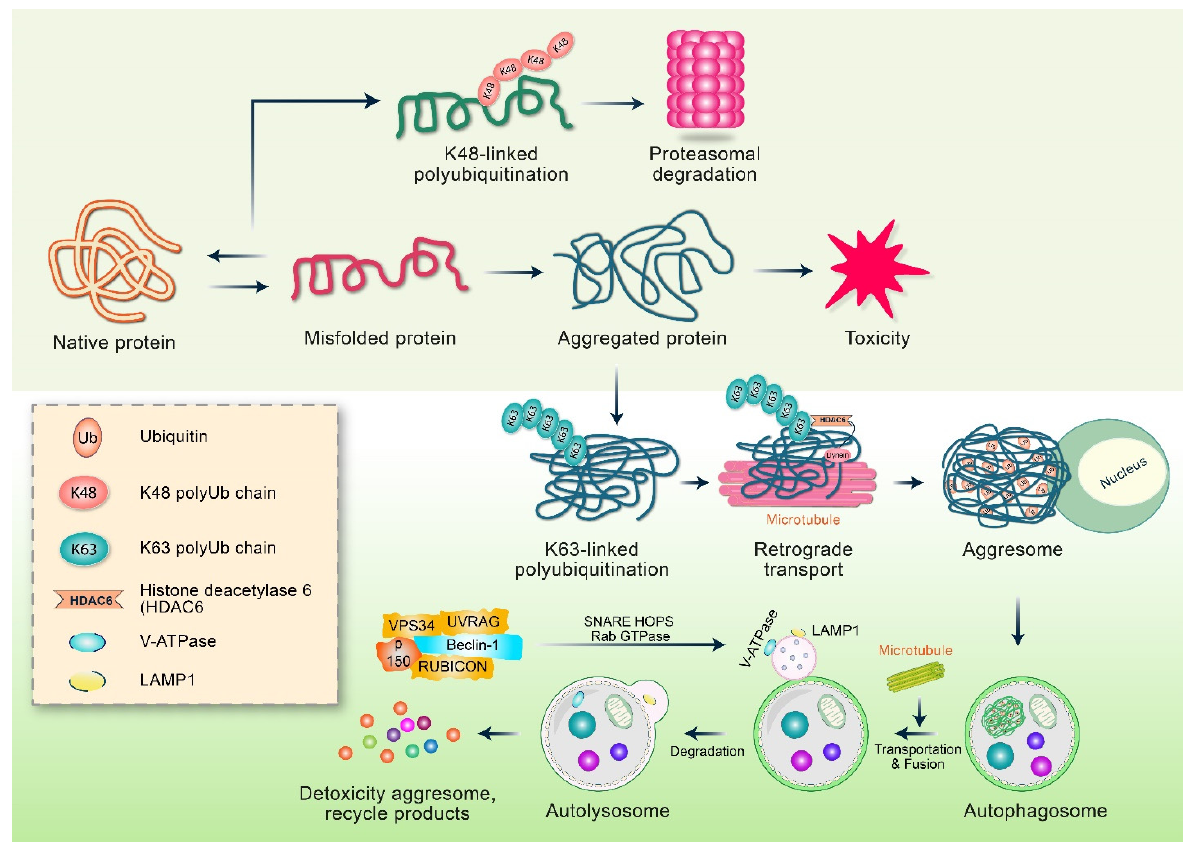
Figure 4. The regulation of aggresome–autophagy pathway. Aggresome and autophagy are regulated by Lys63-associated polyquitination-mediated pathway. Oxidative damage or genetic mutations are responsible for protein misfolding. After folding, the misfolded proteins are labeled with polyubiquitin chains linked to Lys48, which is subsequently degraded via either the proteasomal system or chaperone-mediated pathway. However, when proteasome and chaperone systems are overwhelmed, misfolded proteins form oligomers or aggregates with cellular toxicity. Moreover, PD-related parkin ligase E3 acts with the E2 enzymes Ubc13/Uev1a to facilitate Lys63-associated polyubiquitination of misfolded proteins in proteasome injury conditions. Polyubiquitin chain stimulates binding with HDAC6, and the misfolded proteins bind to dynein motor complex, which retrograde the aggresomes to MTOC via transport. Polyubiquitination encourages p62 binding in addition to recruiting autophagic membranes to form autophagosomes. Consequently, the fusion of autophagosomes and lysosomes facilitates the degradation of misfolded and aggregated proteins through the lysosomal hydrolases.